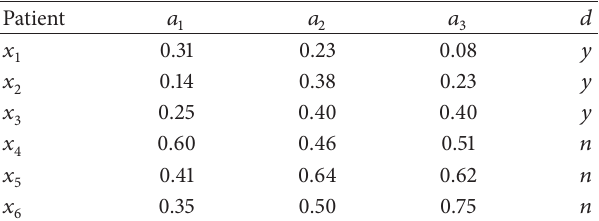
Table 4: A subtable of the Liver decision system.